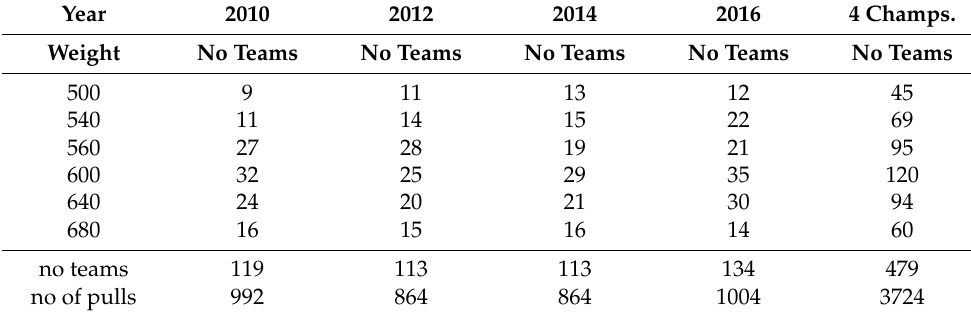
Table 1. Number of teams and weight characteristics of the participants in four World